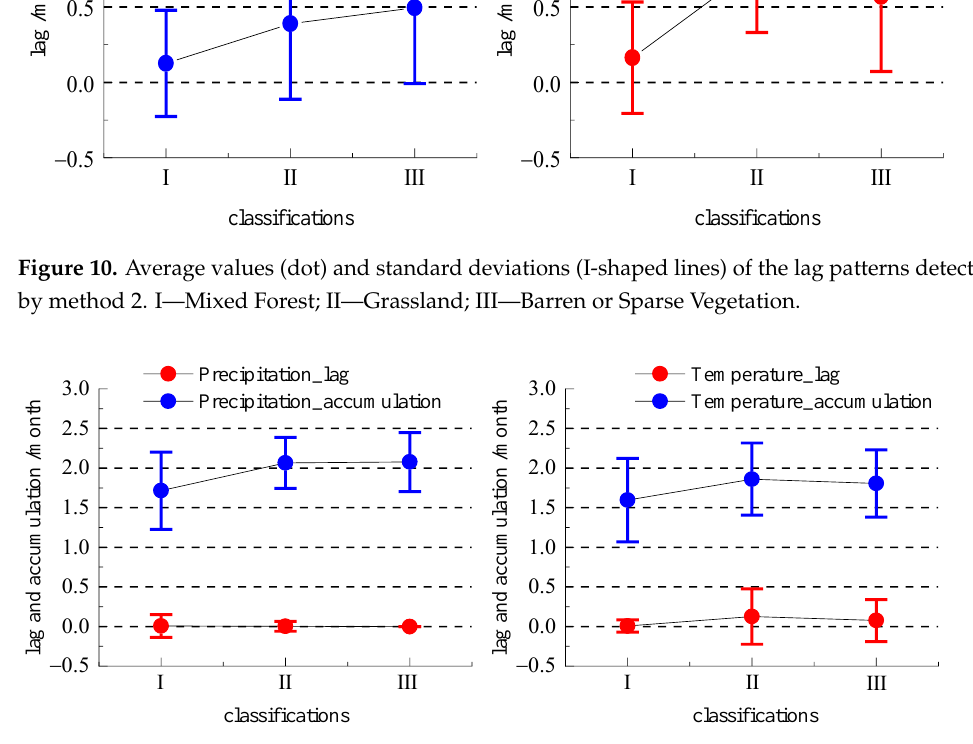
Figure 11. Average values (dot) and standard deviations (I-shaped lines) of the lag patterns detected by method 3. I—Mixed Forest; II—Grassland; III—Barren or Sparse